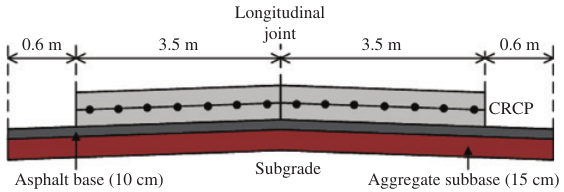
Figure 1: Typical section for